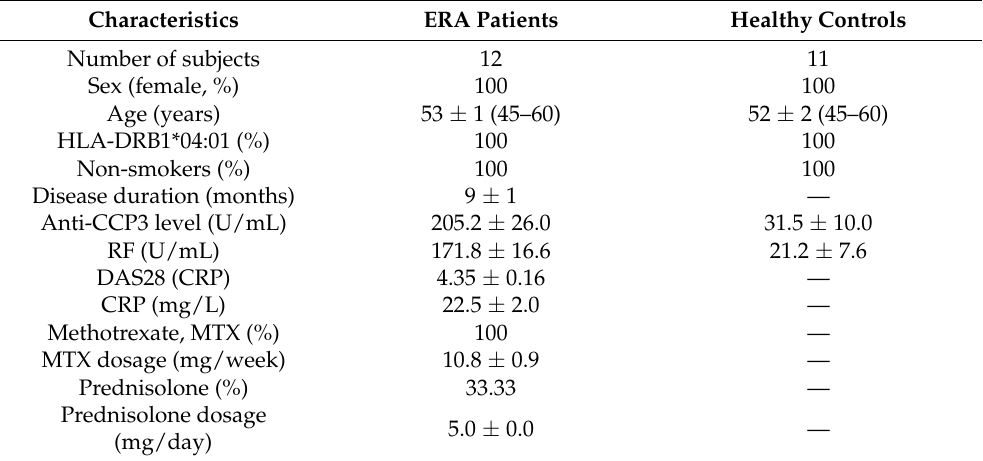
Table 4. Baseline demographic and disease characteristics * of ERA patients and healthy